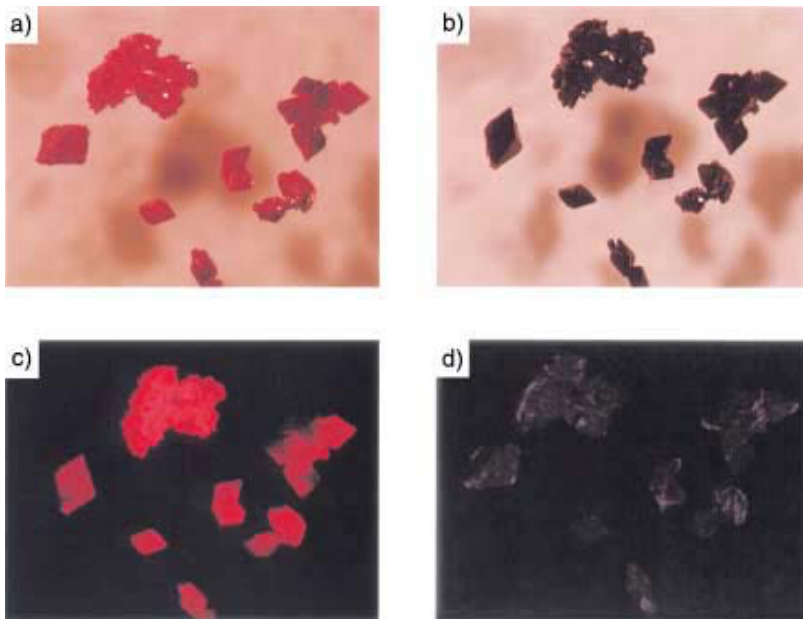
Figure 10. Photographic images of crystals of the syn isomer, illustrating vapochromic effects: (a) the light-red (desolvated) form in air and, (b) the dark-red form after exposure of (a) to acetonitrile vapor. Luminescence images of: (c) the light-red, and (d) dark-red forms. Reproduced with permission from